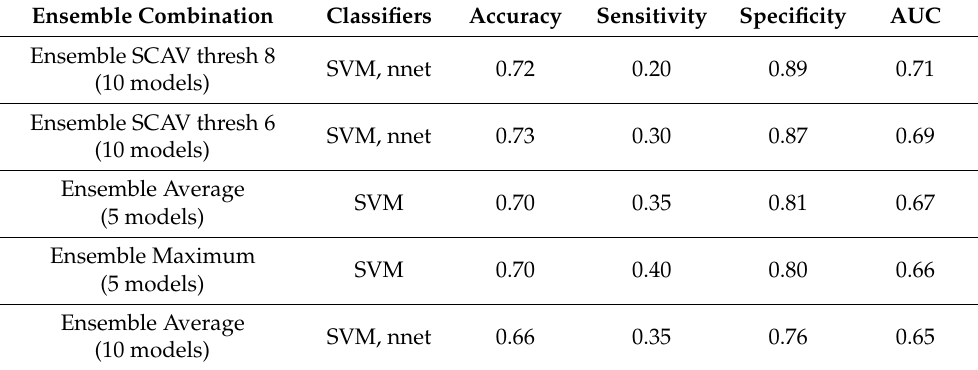
Table 6. KRAS mutation prediction best results on Test dataset, ensembles.